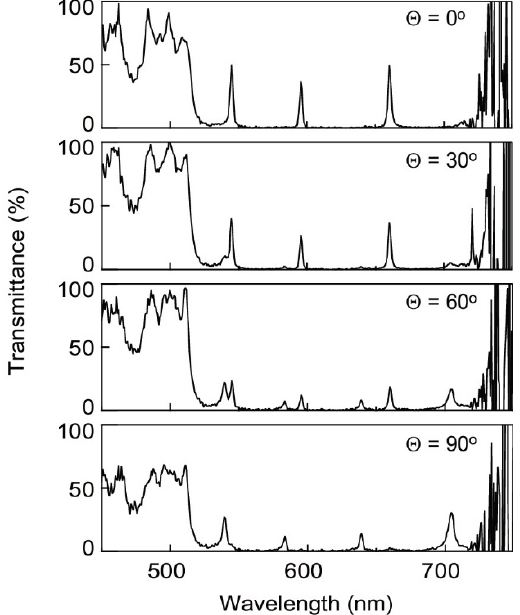
Figure 4. Transmission spectra of the 1D PC with the NLC defect for analyzer angles: Θ = 0°, 30°, 60°, and